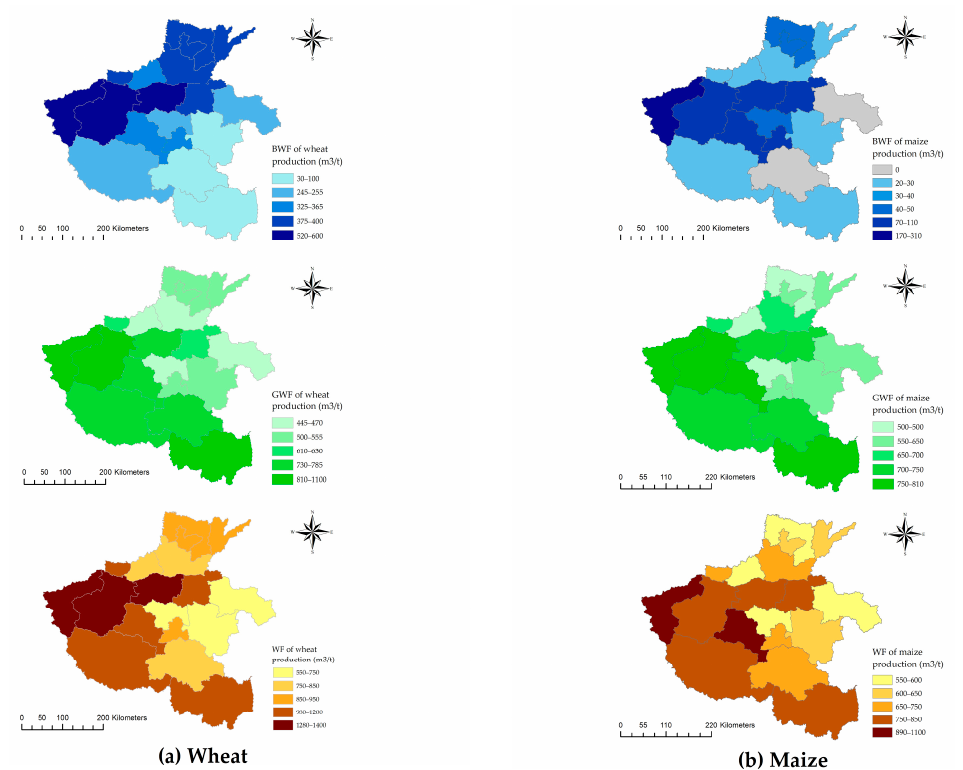
Figure 2. The spatial distribution of the blue, green, and total WF (m 3 /t) of wheat and maize production in Henan Province.